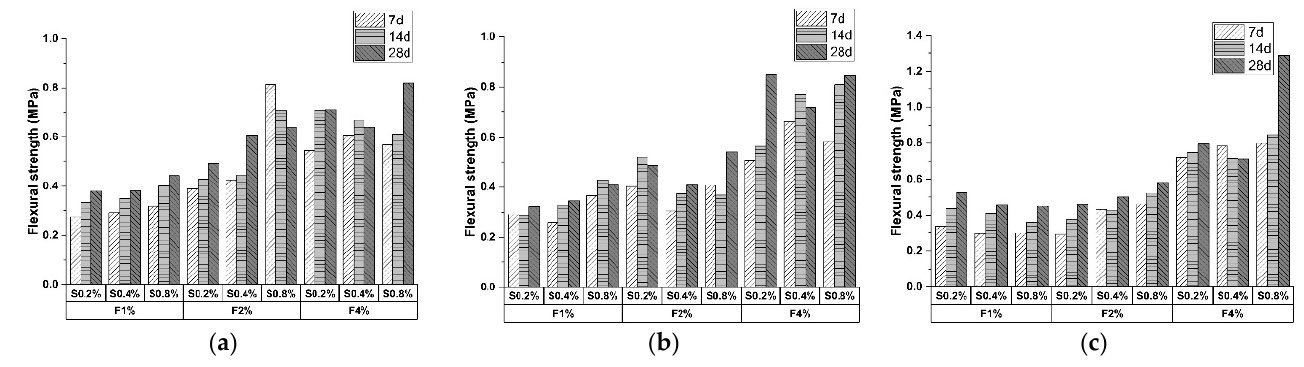
Figure 7. Flexural strength of 20% cement specimen with ( a ) 10% C&D waste; ( b ) 20% C&D waste; ( c ) 30% C&D waste (Note: S represents sodium sulfate; F represents polypropylene fiber).